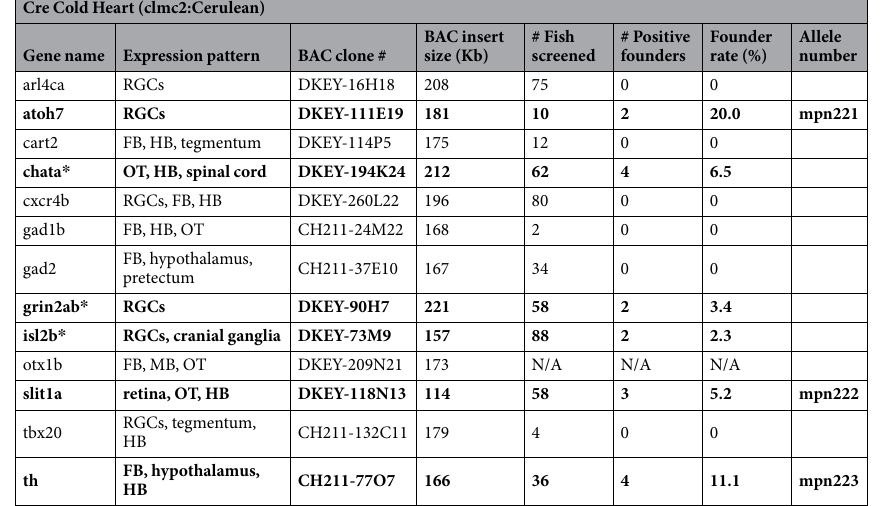
Table 2. List of Cre-Cold Heart constructs and transgenic lines. 12 Cre-Cold Heart BAC constructs have been generated and validated to express Cre after transient injection. Expression pattern is derived from previously reported expression data. Founder rate is defined as a percentage of germline founders out of total adult fish screened. Bold texts indicate the constructs from which CH-positive transgenic line(s) were isolated. FB, forebrain; MB, midbrain; HB, hindbrain; RGCs, retinal ganglion cells; OT, optic tectum; * lines discontinued. N/A, line has not been screened for founders. otx1b:Cre BAC was generated without the Cold Heart